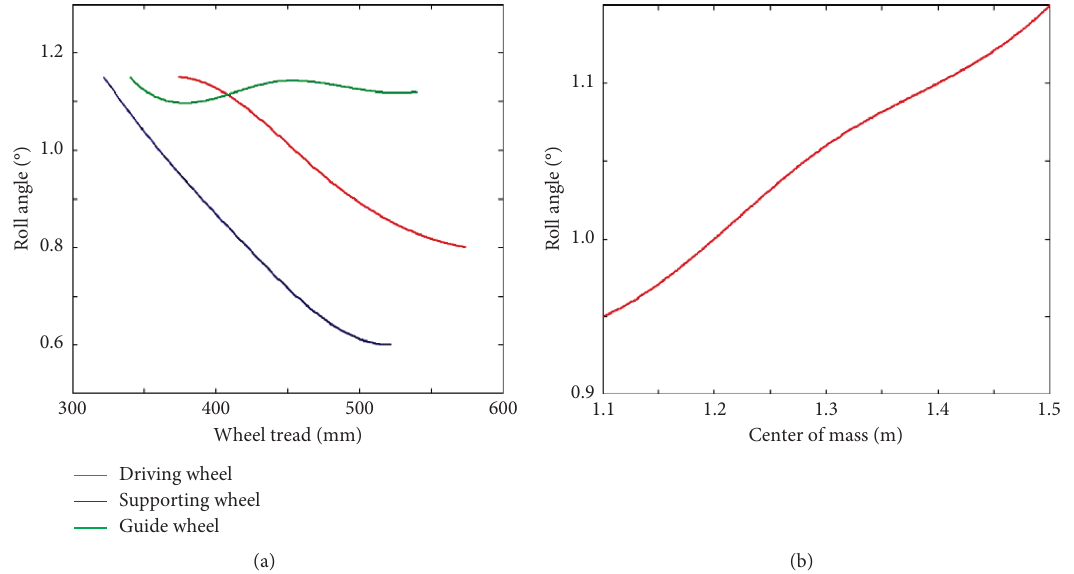
Figure 11: Variations of the amplitude of the roll angle with the design parameters of the bogie on straight driving: (a) wheel tread and (b) center of mass.